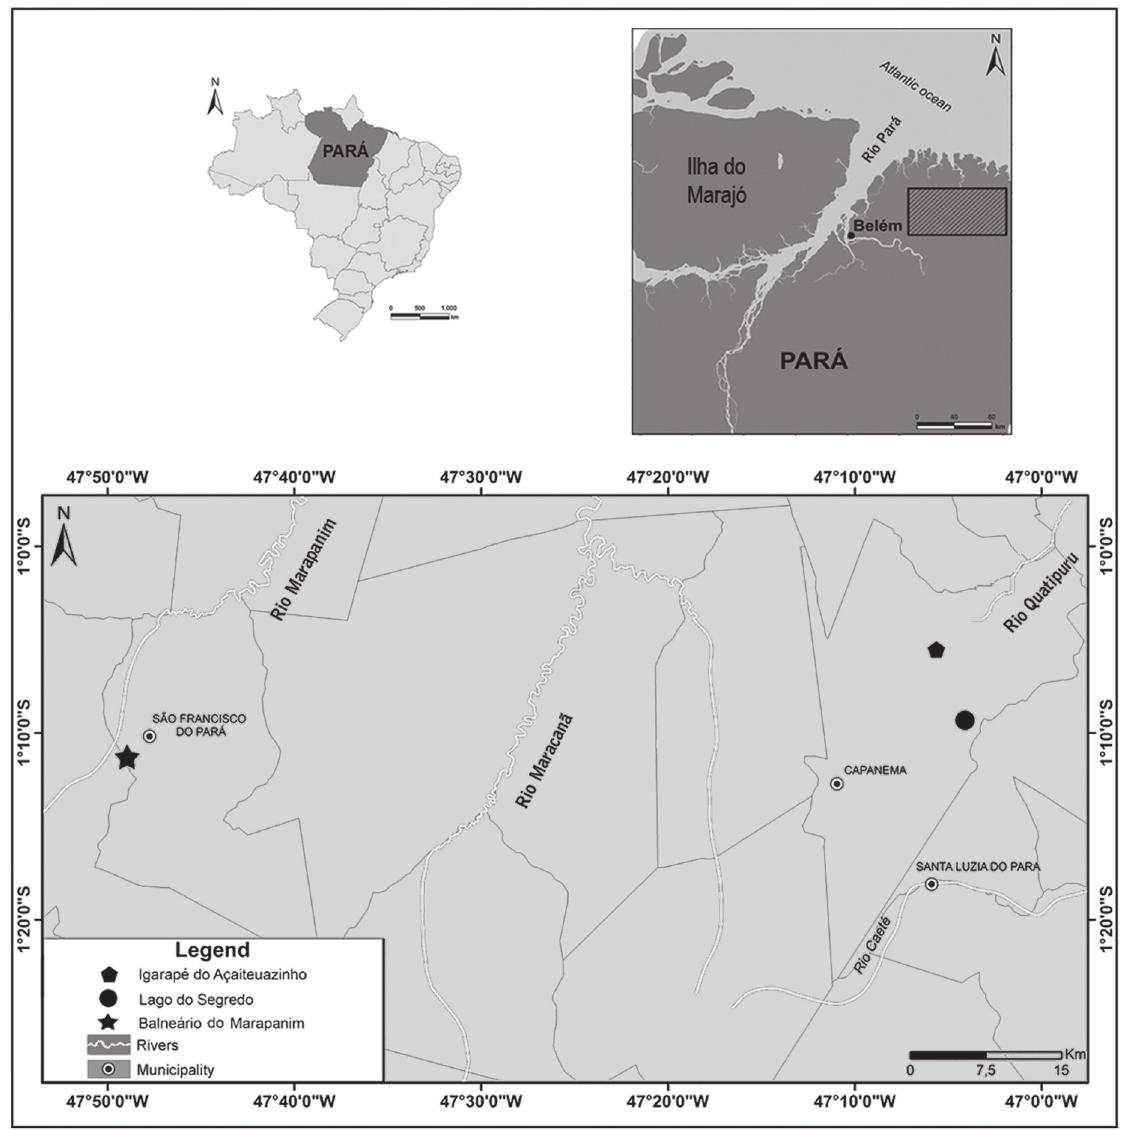
Fig. 1. Map of localities where Eigenmannia samples were collected. Table 2. Localities of the samples of Eigenmannia in north-eastern Pará State. ? = undetermined sex. Locality River Sample size (by gender) Latitude and Longitude